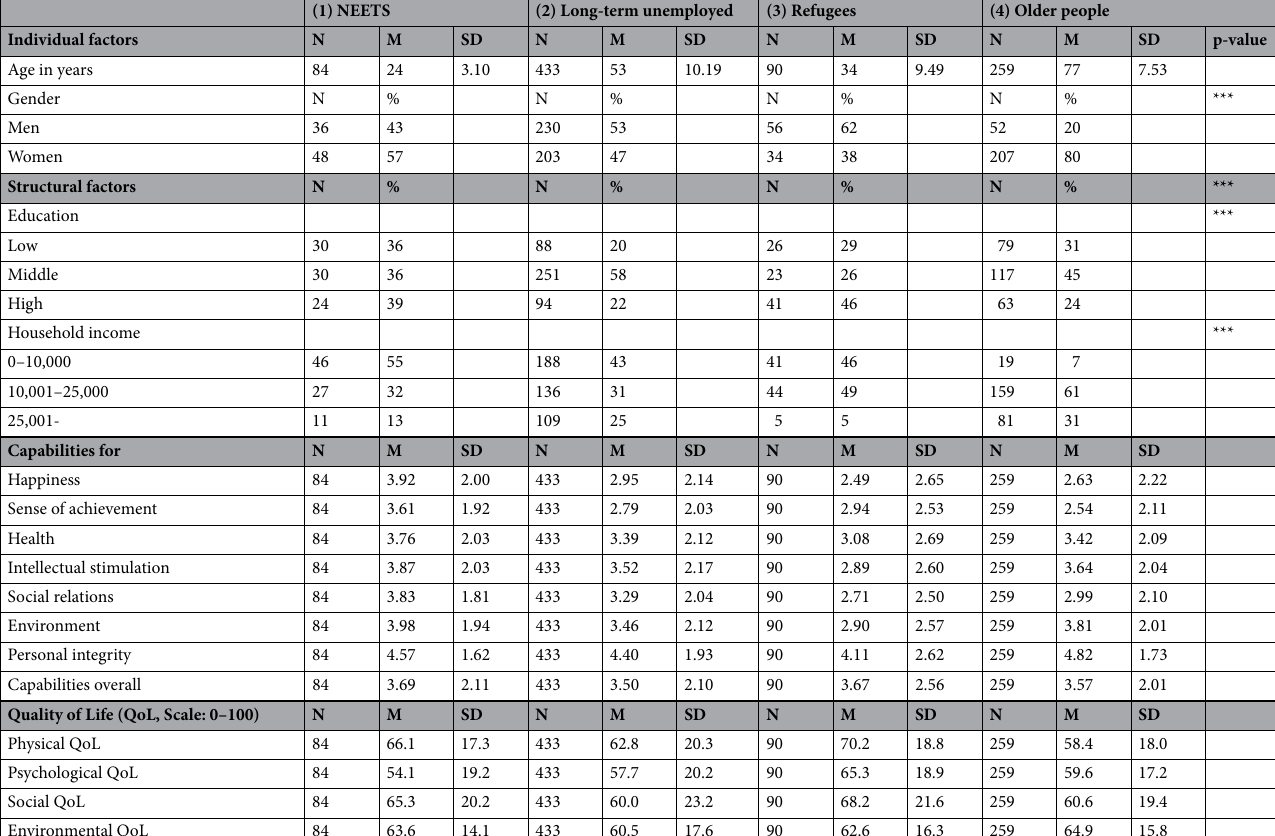
Table 1. Descriptive results of the examined groups, PROMEQ baseline data 2017, N = 866. Number of participants (N), Mean (M), standard deviation (SD), percentage (%) and Pearson Chi2 statistical significance of group differences